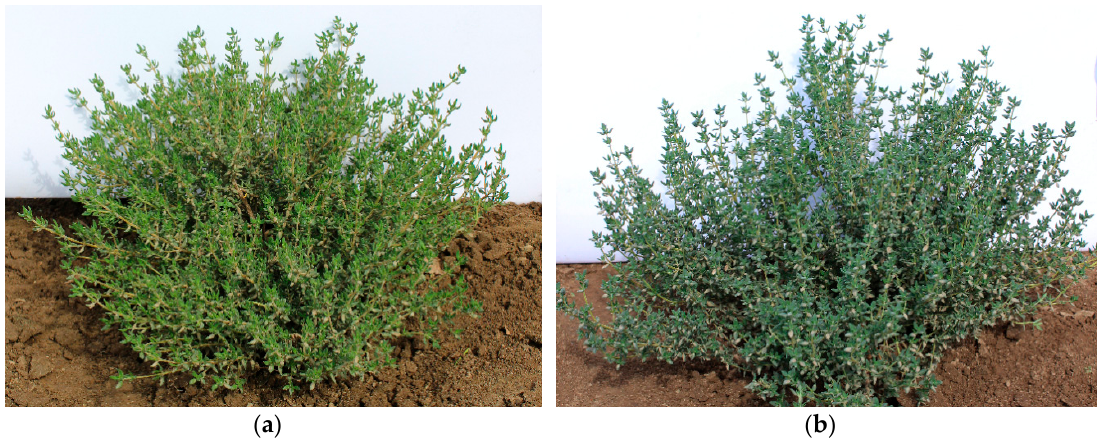
Figure 1. ( a ) Plant of clone no 2; ( b ) Plant of clone no 5.